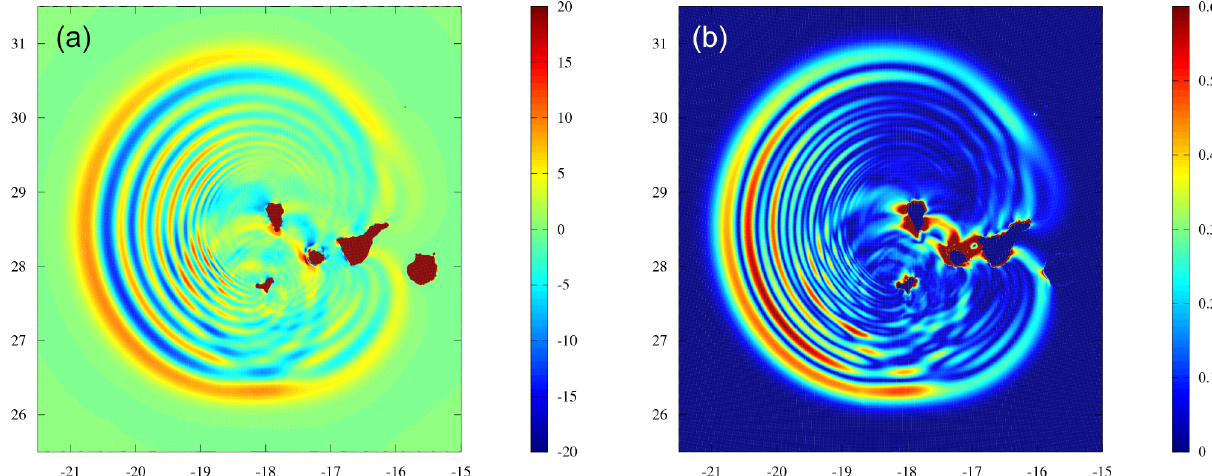
Figure 16. Region around the Canary Islands 20min after the beginning of the event (after 5min of simulated time with THETIS and 15min of simulated time with FUNWAVE-TVD) during the 80km 3 slide volume scenario: (a) wave elevation and (b) horizontal water velocity